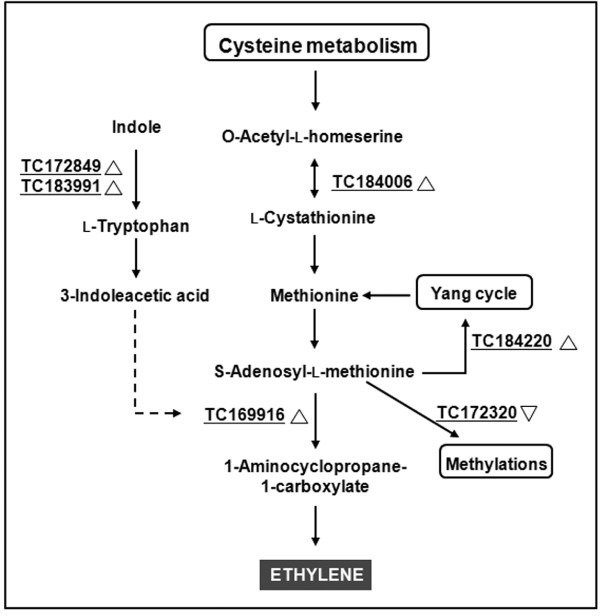
Network showing the differential expression (between IL 12-4 and M82) of genes associated with ethylene metabolism. Underlined TCs are differentially expressed in the microarray experiment, with upright triangles representing upregulation and inverted triangles representing downregulation. Dashed line indicates an external supply that can enhance enzyme activity.